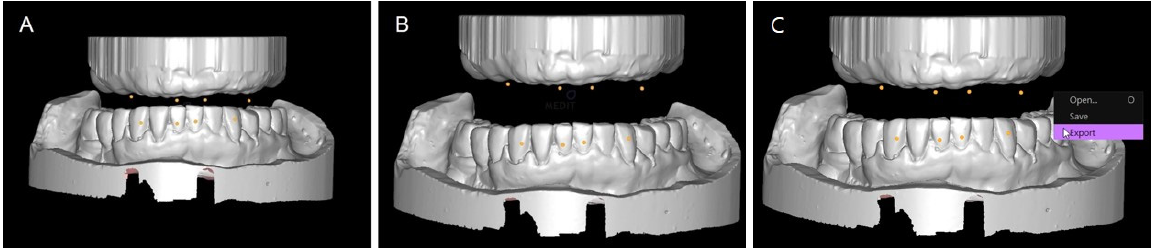
Figure 3. ( A ) Selecting the intaglio surface of the denture. ( B ) Producing a digital edentulous model using the “flip” function.